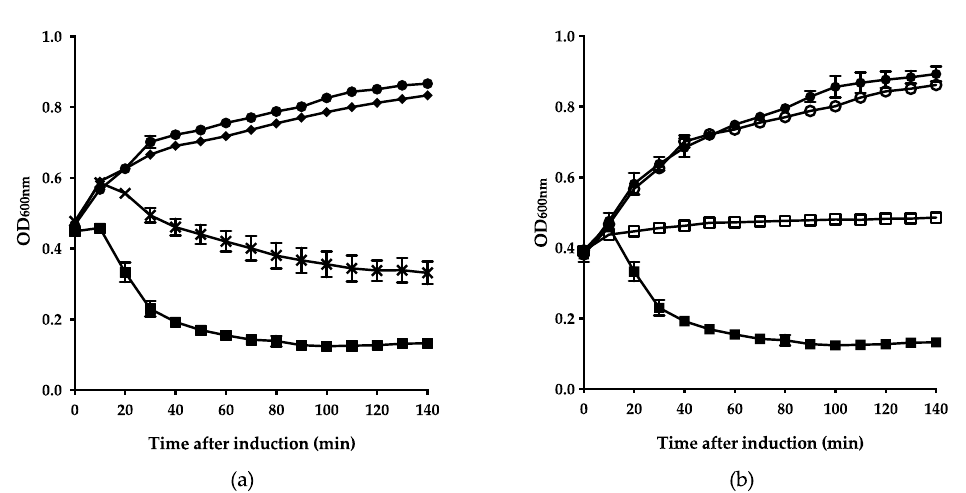
Figure 4. Firehammervirus phage F379 endolysin relies on the Sec-pathway for translocation but causes cell lysis independent of a holin. (a) Growth of E. coli cells expressing predicted lytic proteins. Optical density (OD 600 ) of cells expressing endolysin ( ); lysis inhibitor ( ) and co-expression of lysis inhibitor and endolysin ( × ) was compared to E. coli cells carrying empty vector ( ● ). (b) Dependence of the predicted endolysin on the Sec-pathway. To investigate the dependence of the endolysin on the Sec-system, cells expressing the endolysin were cultured in the presence of sodium azide (NaN 3 ) ( ☐ ) or absence ( ). The growth of cells carrying the empty vector with ( ○ ) and without ( ● ) NaN 3 served as negative controls.